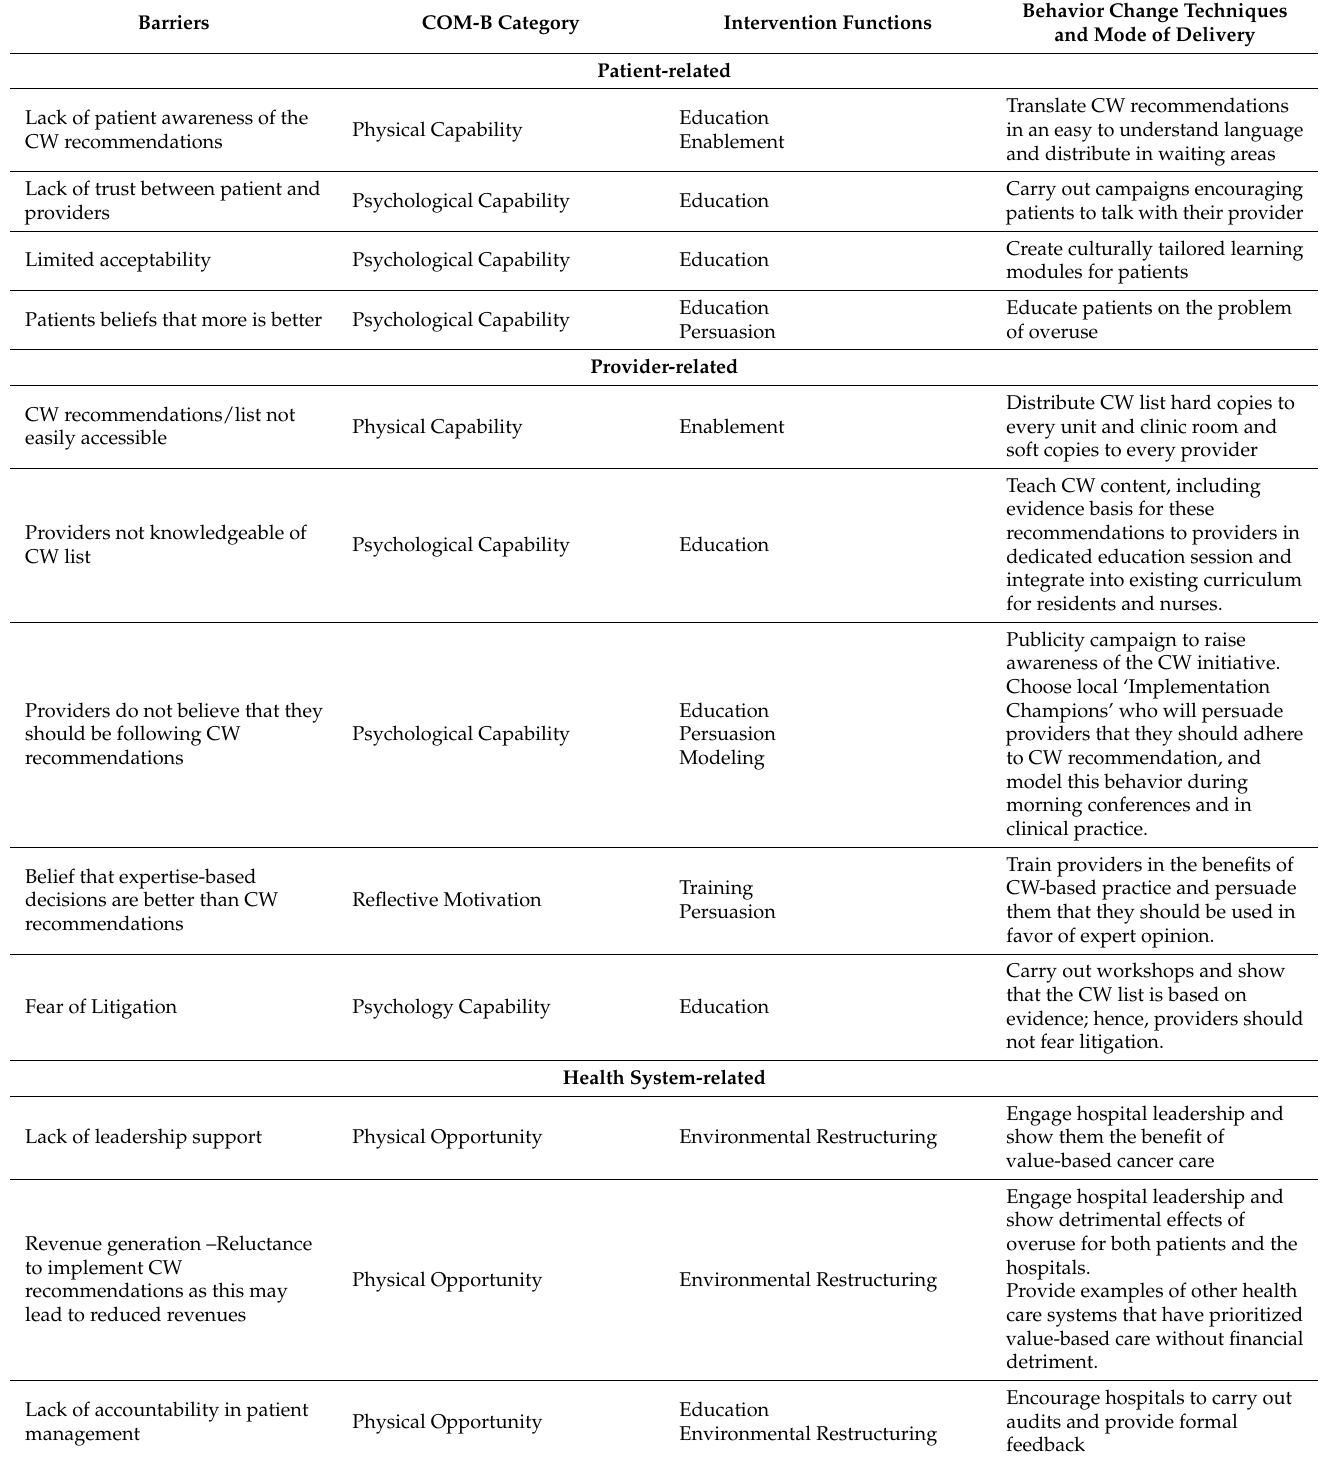
Table 1. COM-B Model and Barriers to Implementation of the CW